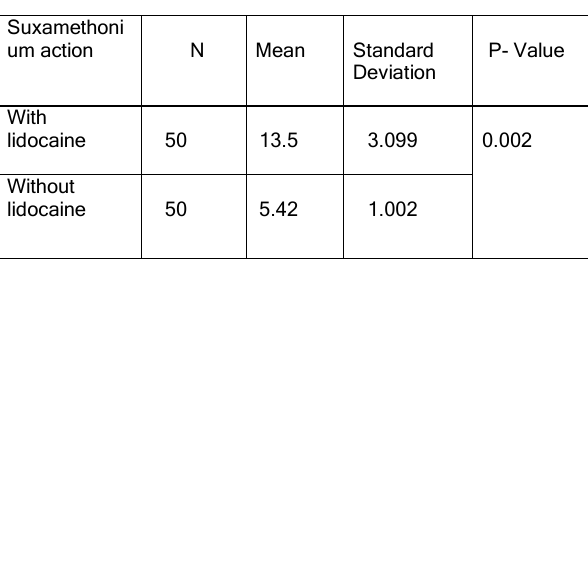
Table I : comparison of Time of Suxamethonium action with Lidocaine administration 3 minutes